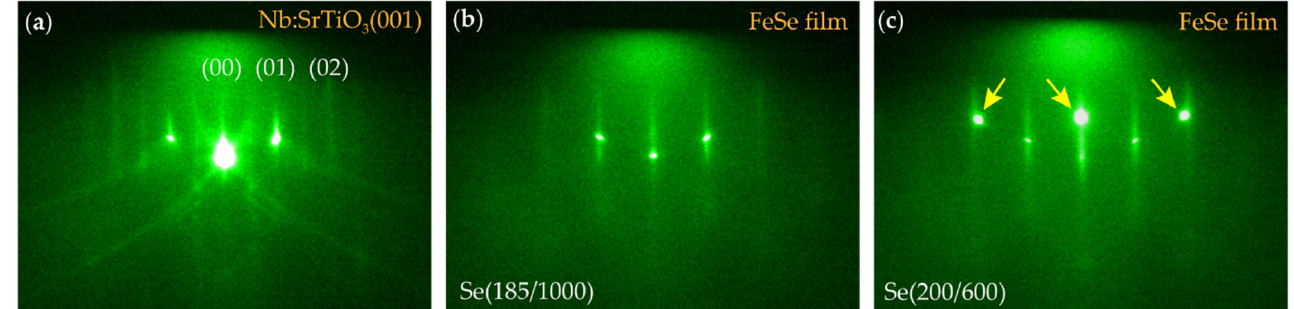
Figure 2. RHEED images of ( a ) treated STO substrate, ( b ) FeSe film grown for 5 min with Se(185/1000), and ( c ) FeSe film grown for 5 min with Se(200/600). The additional spots marked by the arrows in ( c ) indicate the formation of Fe islands.